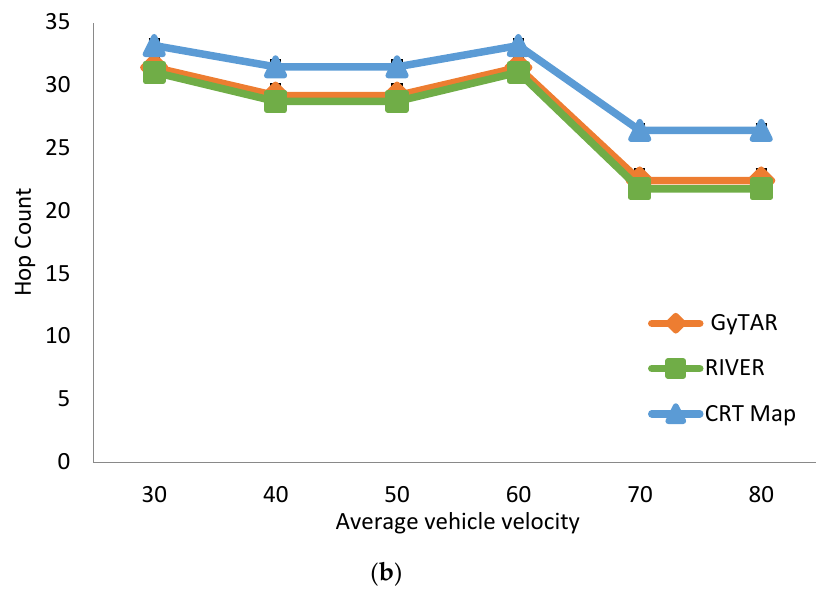
Figure 11. Average hop count vs. moving speed: ( a ) 100 vehicles; and ( b ) 300 vehicles.